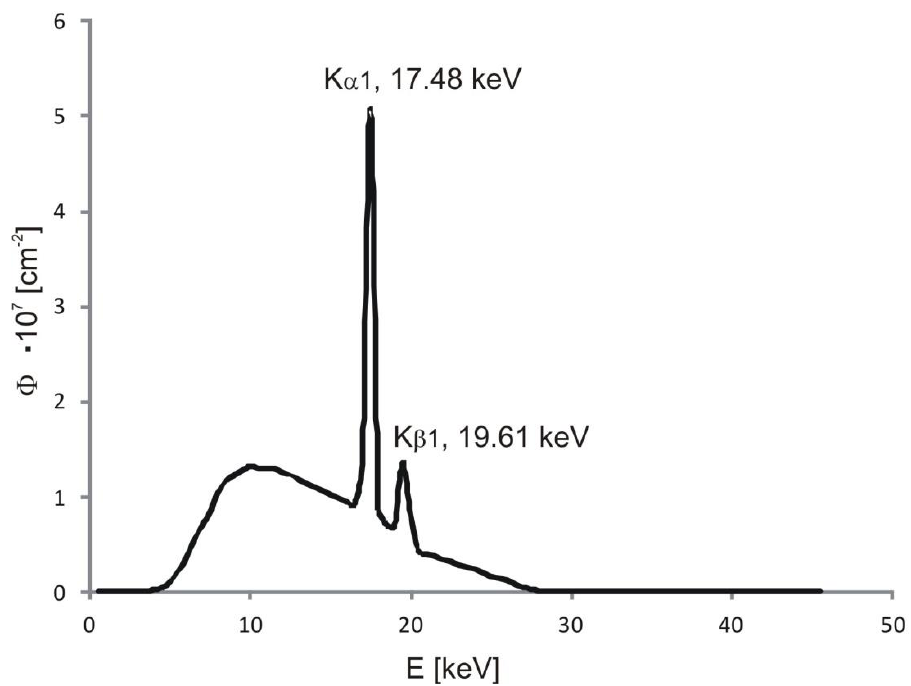
Figure 2. Sample spectrum used in simulations, generated for a molybdenum anode at a voltage of 28 kV. The K α1 and K β1 emission lin es are visible. Φ, photon fluence; E, energy of photons.